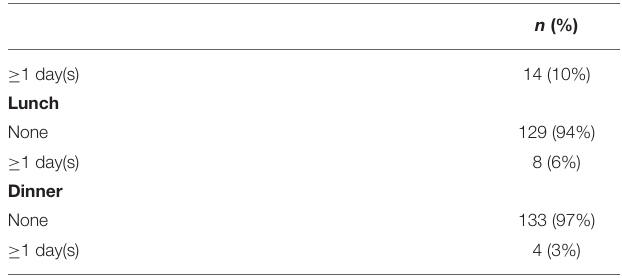
TABLE 2 | Health and lifestyle characteristics of participants ( n = 137).